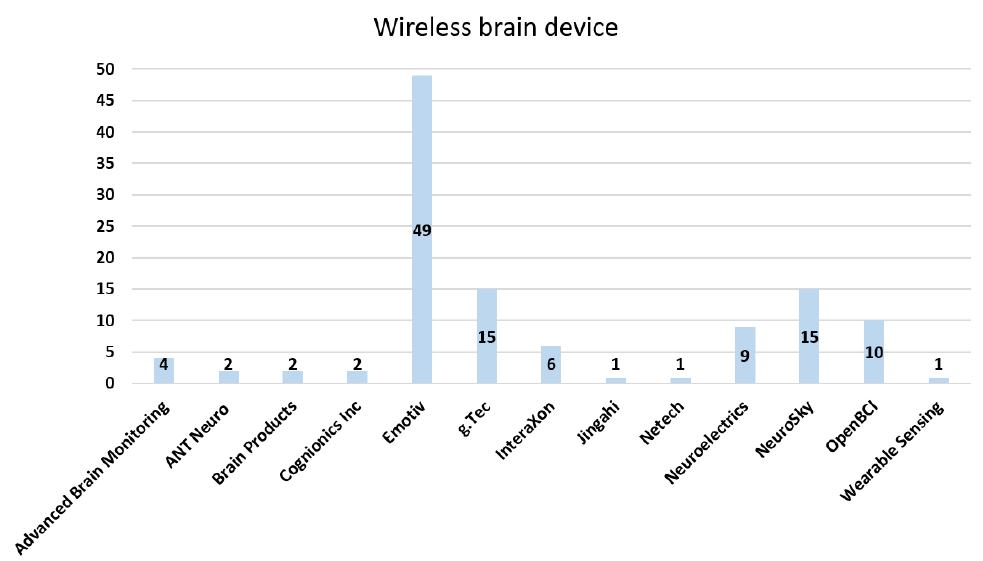
Figure 7. Proportion chart of companies that used noninvasive wireless